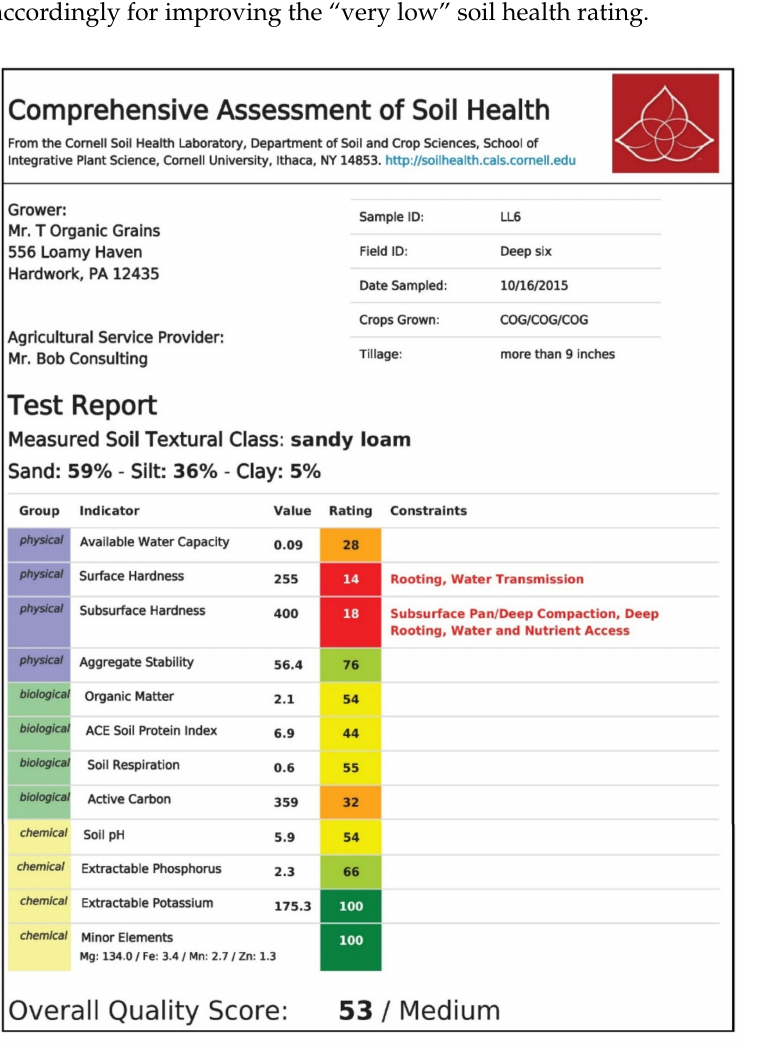
Figure 4. A comprehensive soil health assessment report example illustrating the assessment score, overall health, and main constraints of a cropland soil [13]. Red, orange, yellow, light green, and dark green indicate very low, low, medium, high, and very high in soil health rating,